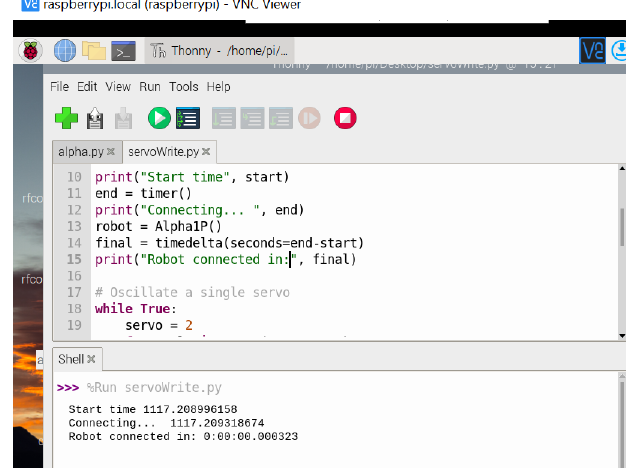
Figure 19. Raspberry Pi connection to Alpha 1P Robot. The Bluetooth latency, representing Alpha 1P robot’s execution of a certain action, was 3.66 s for Raspberry Pi, as shown in Figure 20.